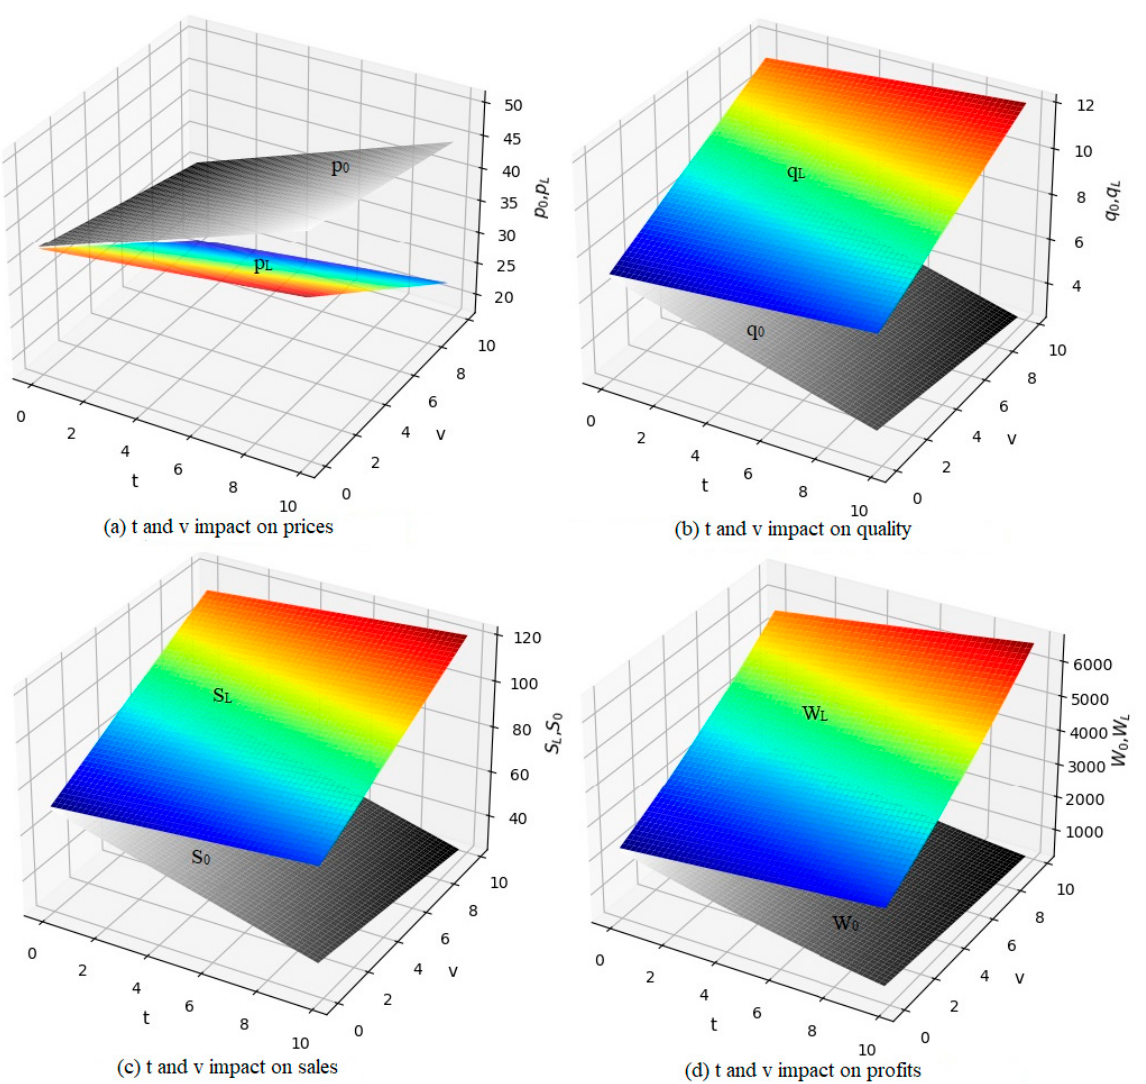
Figure 3. The influence of the government’s t and v on the parameters of the two products.